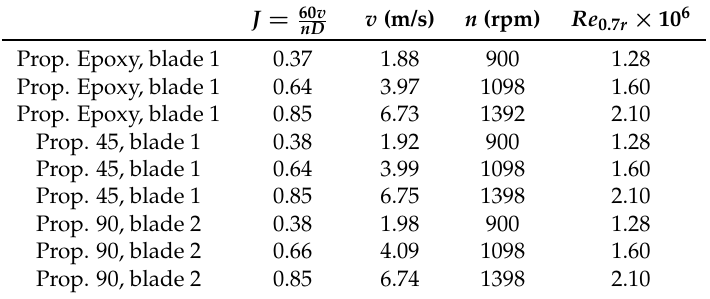
Table 3. Flow conditions for the flexible propeller calculations and measurements.